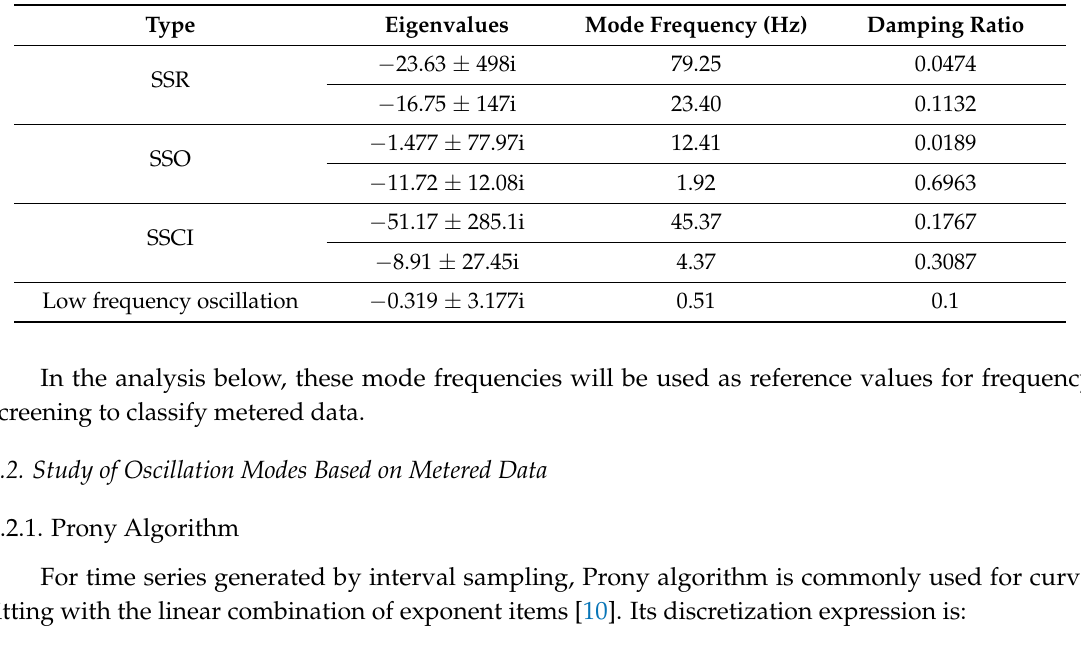
Figure 2. Small-signal model of DFIG connected to grid.